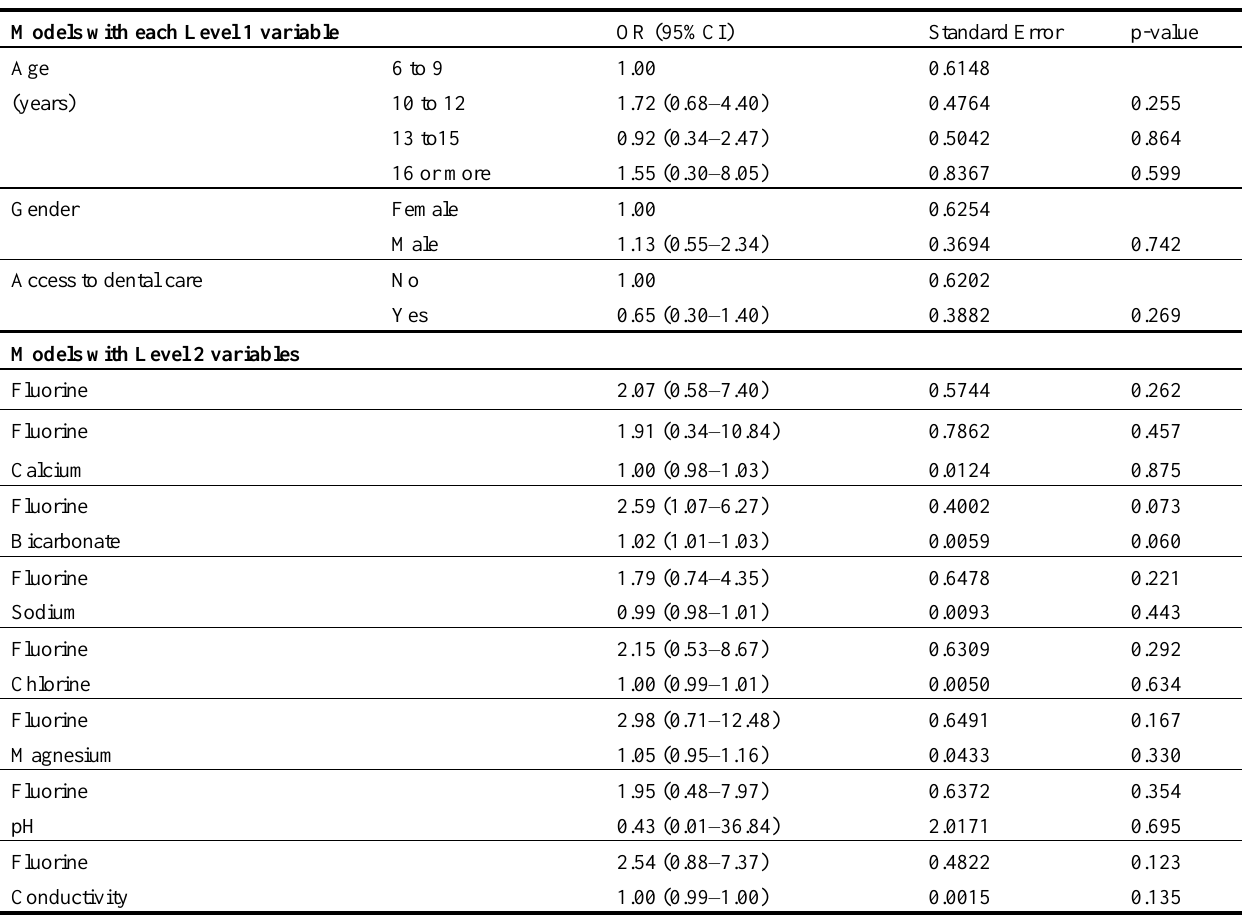
fluorosis in rural communities of São Francisco and Verdelândia,